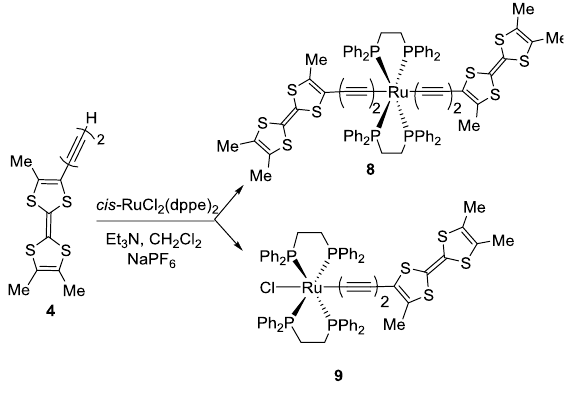
Figure 2. Molecular structure of trans -[RuCl(–C≡C) 2 –Me 3 TTF (dppe) 2 ] complex 9 (H atoms are omitted for clarity). Ellipsoids are drawn at the 50% probability level.